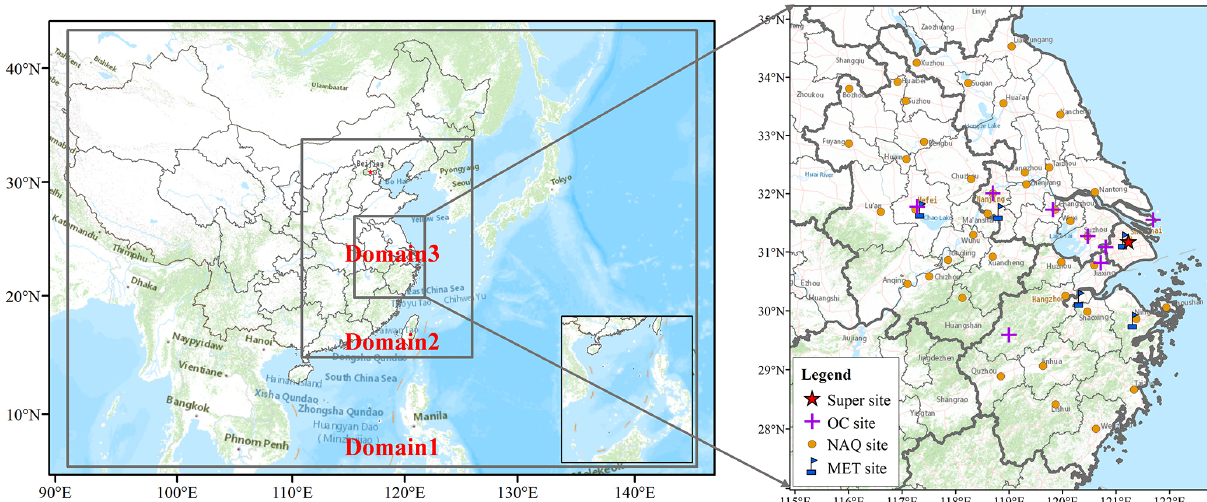
Figure 1. Modeling domain and locations of observation sites. The blue marks are meteorological monitoring sites. The yellow dots represent the national air quality monitoring sites. The purple crosses are the observation sites with PM 2 . 5 chemical composition measurements. The red star represents the observation site of AMS measurement.